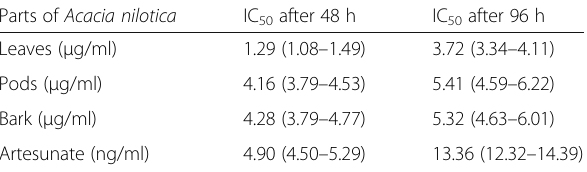
Parameters are presented as mean estimates (95% confidence intervals), after 48 or 96 h of